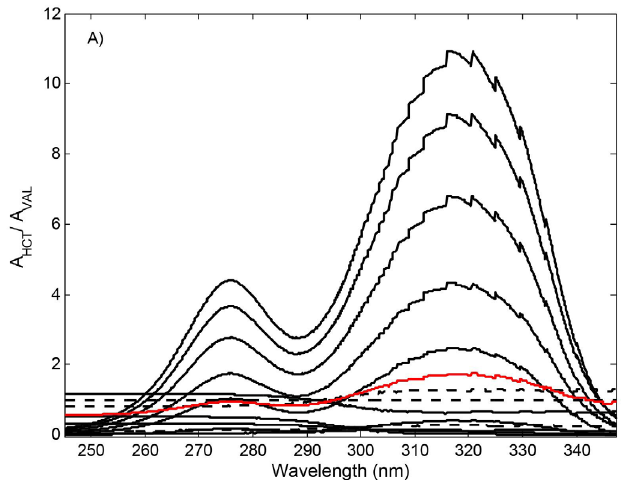
FIGURE 4A - A) Ratio spectra of HCT/VAL, VAL (----) : 1.0, 3.0, 9.0, 15.0, 21.0, 27.0, 33.0 µ g/mL and HCT (  ) : 1.0, 6.0, 11.0, 16.0, 21.0, 26.0 µ g/mL and tablet sample (  ) containing 2.50 µ g/mL of VAL and 16.0 µ g/mL of HCT.